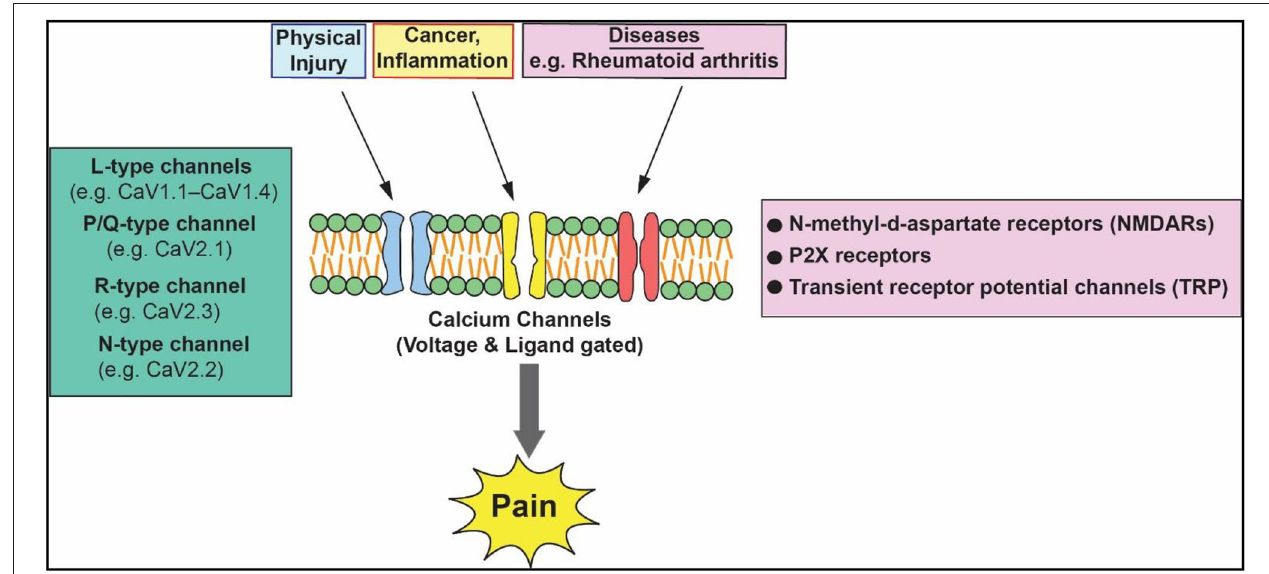
FIGURE 1 | Regulatory action of volltage aged calcium channels in pain